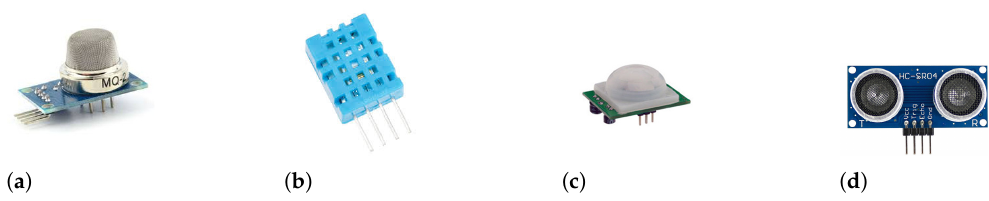
Figure 6. Various sensors used in this work ( a ) Gas ( b ) Temperature and humidity, ( c ) PIR motion, and ( d ) Ultrasonic sensors.